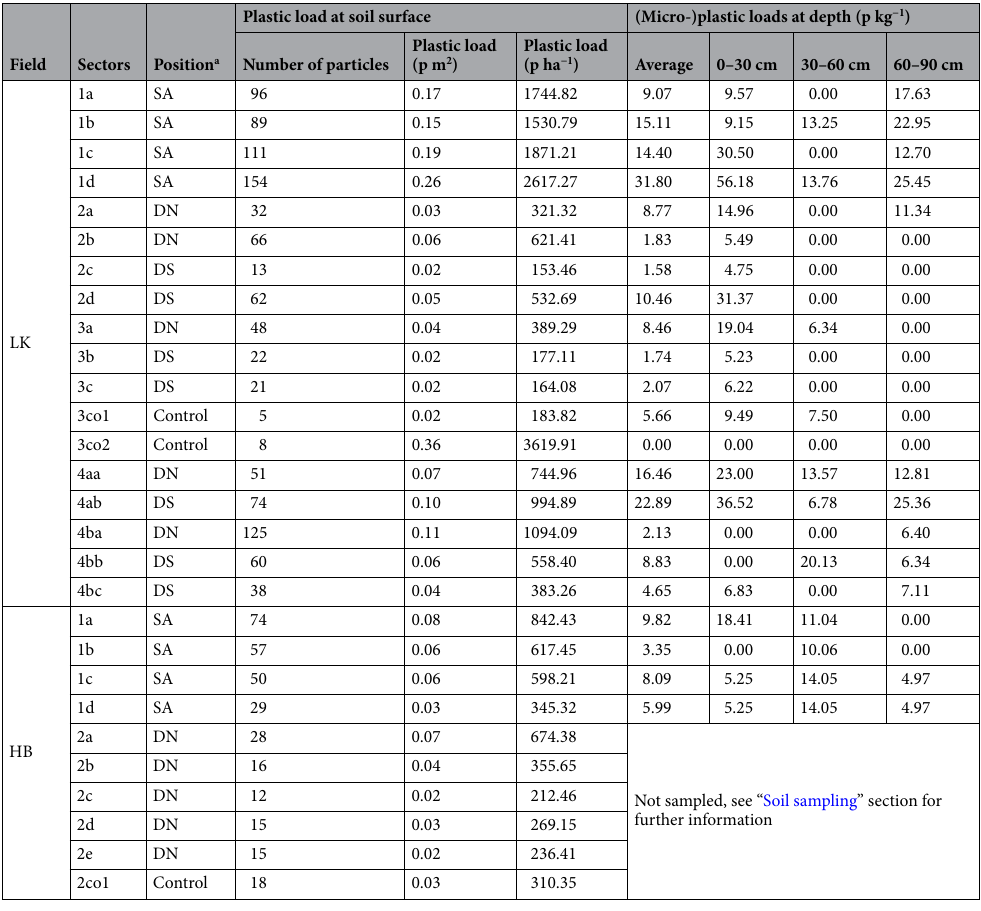
Table 1. Plastic concentrations on soil surfaces and microplastic concentrations in soils according sampling depth and sampling sectors. a Position on agricultural fields: Sludge application area (SA), direct neighbours to SA (DN), distant sectors (DS) and control sectors